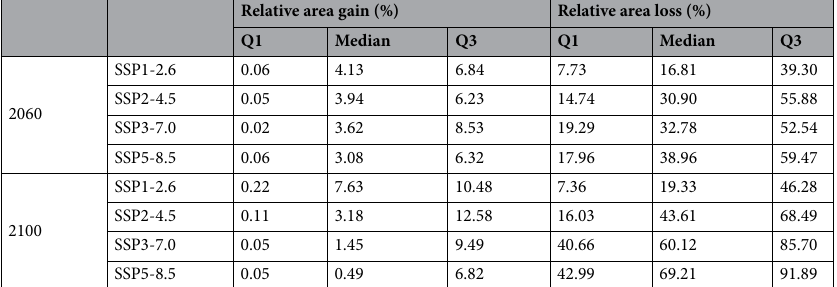
Relative area gain